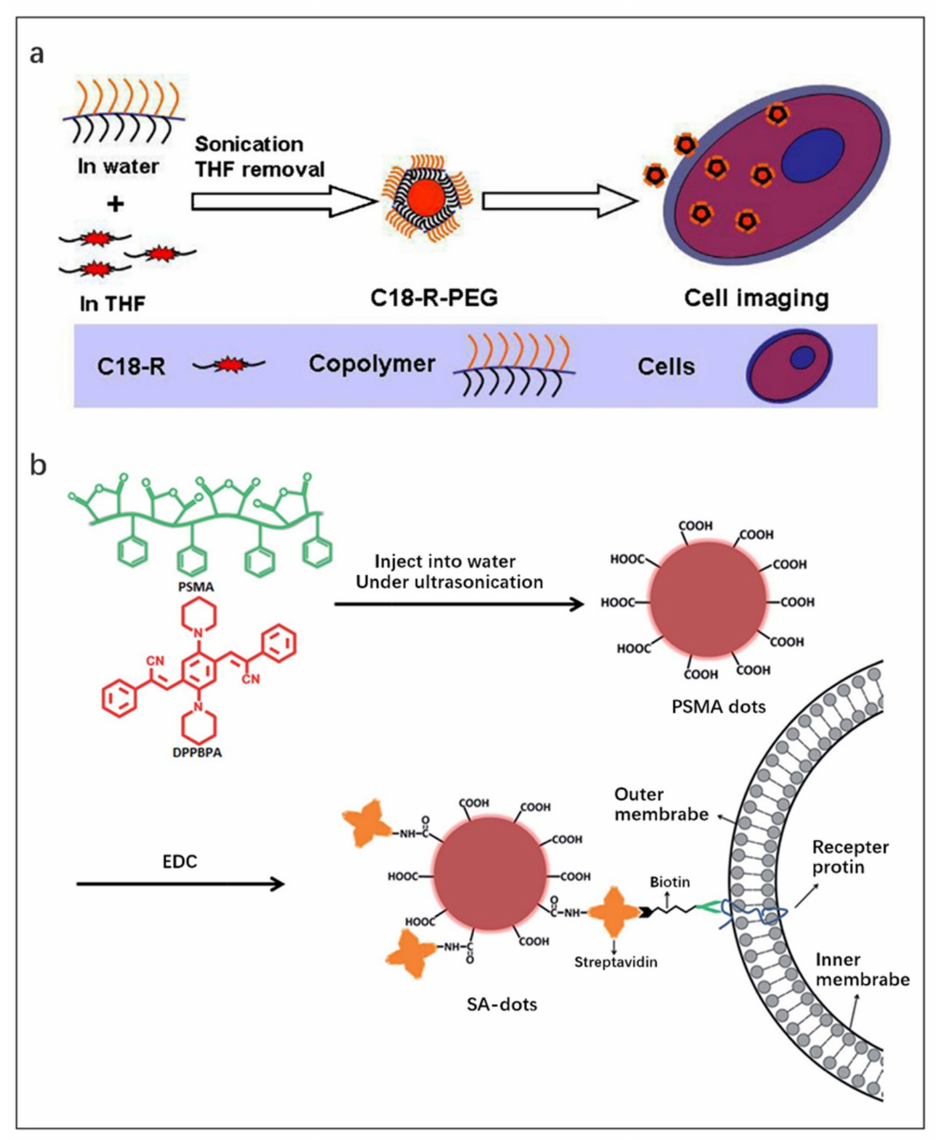
Figure 9. ( a ) Schematic illustration of the formation of C18-R-PEG FONPs via self-assembly of C18-R and synthetic copolymers and their utilization in cell imaging. Reproduced with permission from Ref. [108], copyright 2013, Published by Elsevier B.V. ( b ) Schematic illustration of the preparation of SA-dots via EDC-catalyzed coupling and their subsequent cell marking. Reproduced with permission from Ref. [109], copyright 2015, Royal Society of